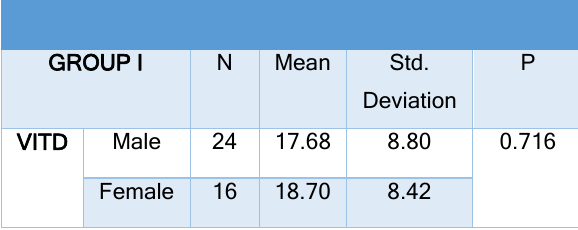
Figure 2 frequency of VDL in PD according to severity of deficiency. Table 4. relation VDL between male and female in